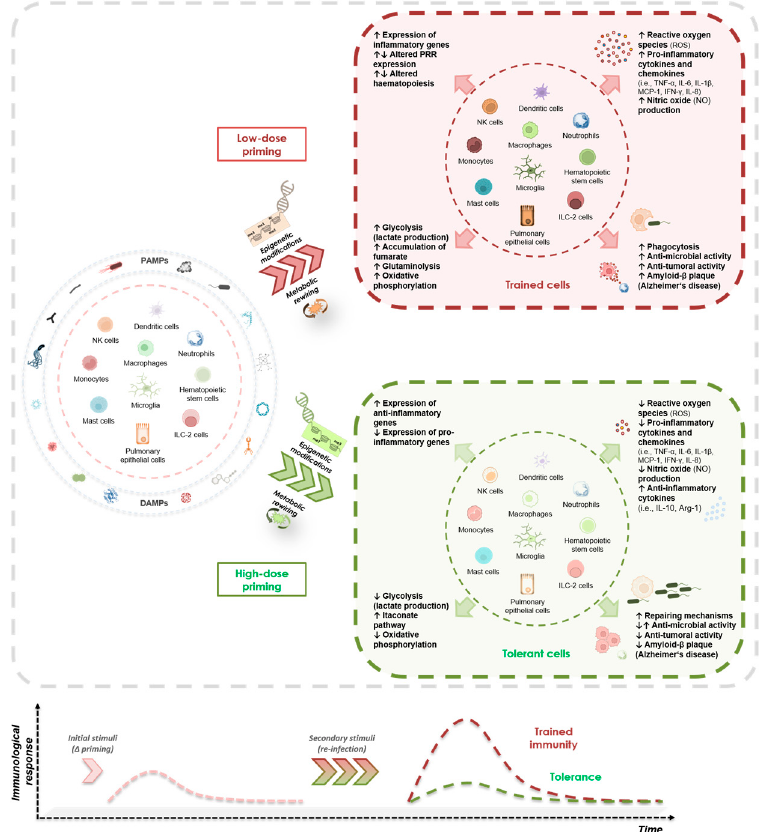
Figure 3. Dose-dependent induction of opposing adaptive inflammatory cues in innate immune system and non-immune cells. Innate immune cells primed by low/single dose PAMPs/DAMPs trigger a trained phenotype after subsequent encounter to a heterologous challenge, whereas high/repeated doses of PAMPs/DAMPs result in an immunotolerant phenotype. Both memory-like manners are mediated by epigenetic modifications with resulting effects on metabolism, altering various functional properties of the cells. This figure serves only for illustrative explanation of the hypothesis, since there are still missing data for such dose–response behaviors for certain types of cells.